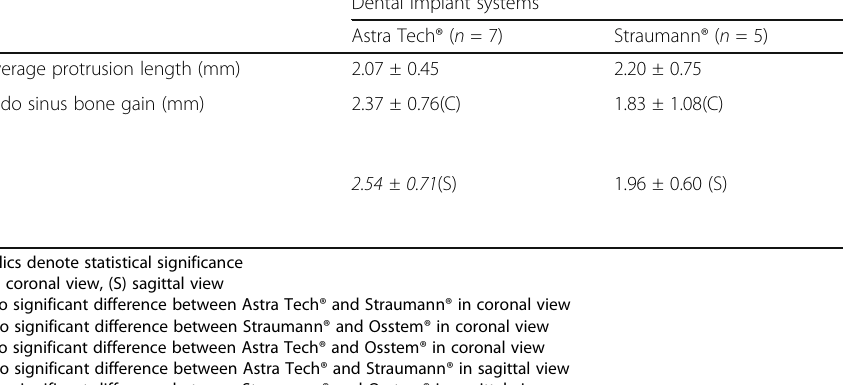
Table 4 New bone formation in relation to the implant system Dental implant